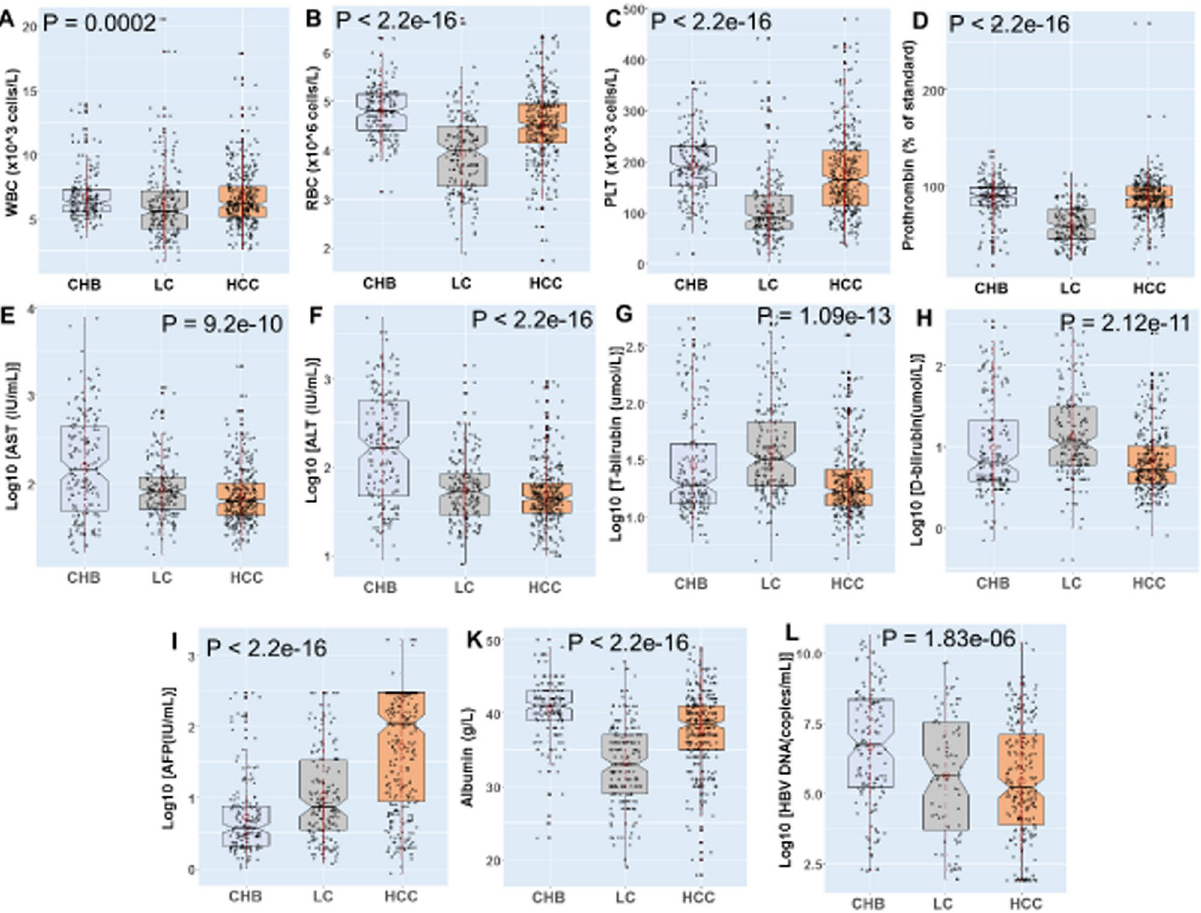
Figure 1. Evaluation of clinical parameters in HBV patient subgroups. CHB chronic hepatitis B, LC liver cirrhosis, HCC hepatocellular carcinoma, PLT platelets, AST and ALT aspartate and alanine amino transferase, WBC white blood cells, RBC red blood cells, PLT platelet, IU international unit. Box-plots illustrate medians with 25 and 75 percentiles with whiskers to 10 and 90 percentiles. p- values were calculated by Kruskal–Wallis